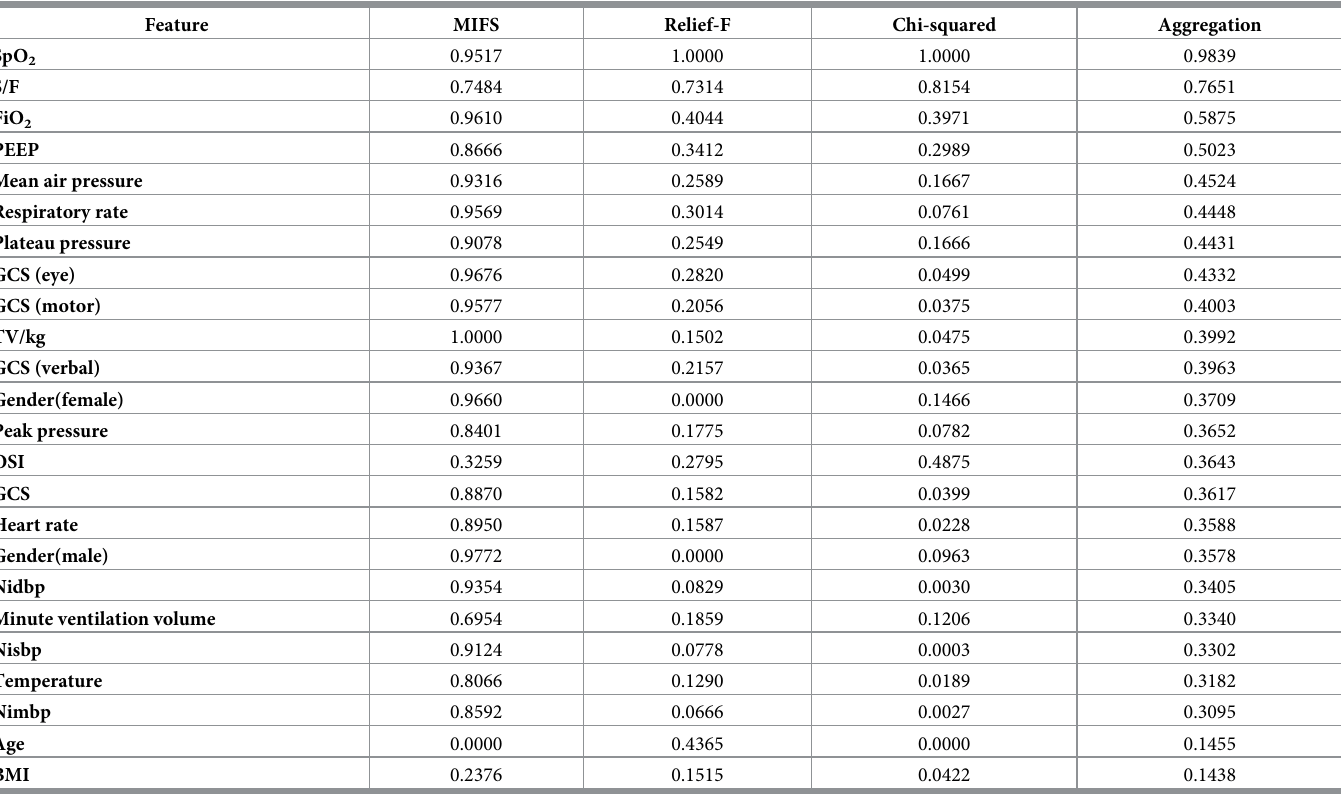
Table 4. Physiological parameter scores and rankings for different feature selection